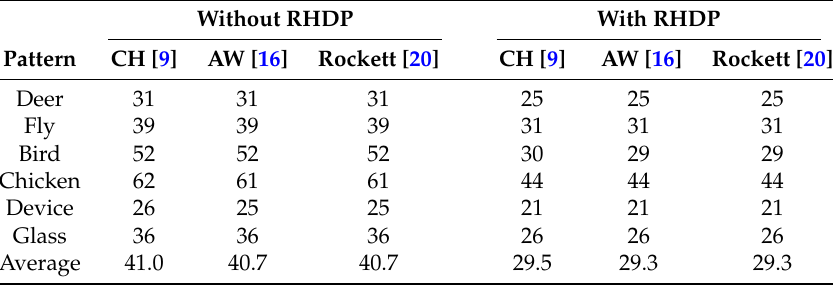
Table 5. NI measurements for the thinning results given in Figures 17 and 18 by applying the presented approach with three fully-parallel thinning algorithms. The average NI with the RHDP process is 28% less than that without the RHDP process.